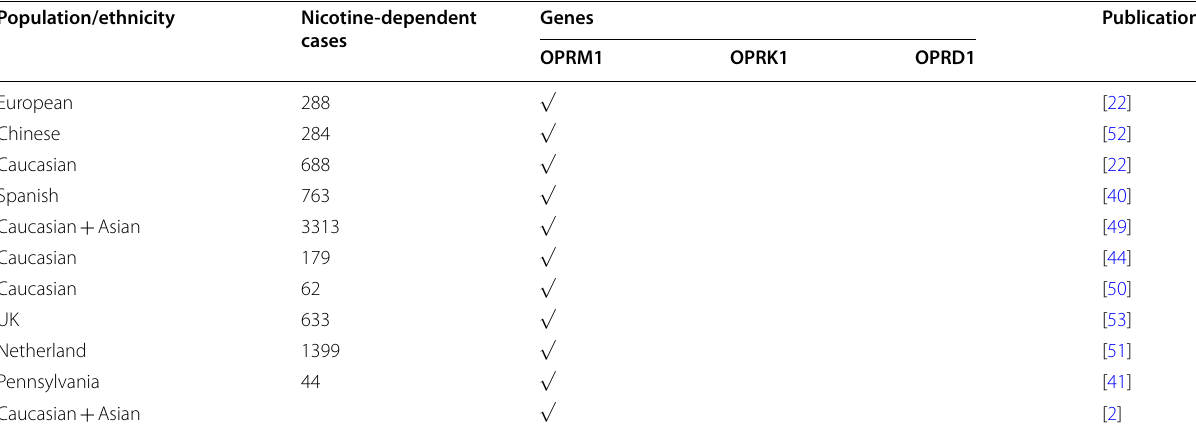
Table 3 Association and pathway studies of nicotine/smoking addiction